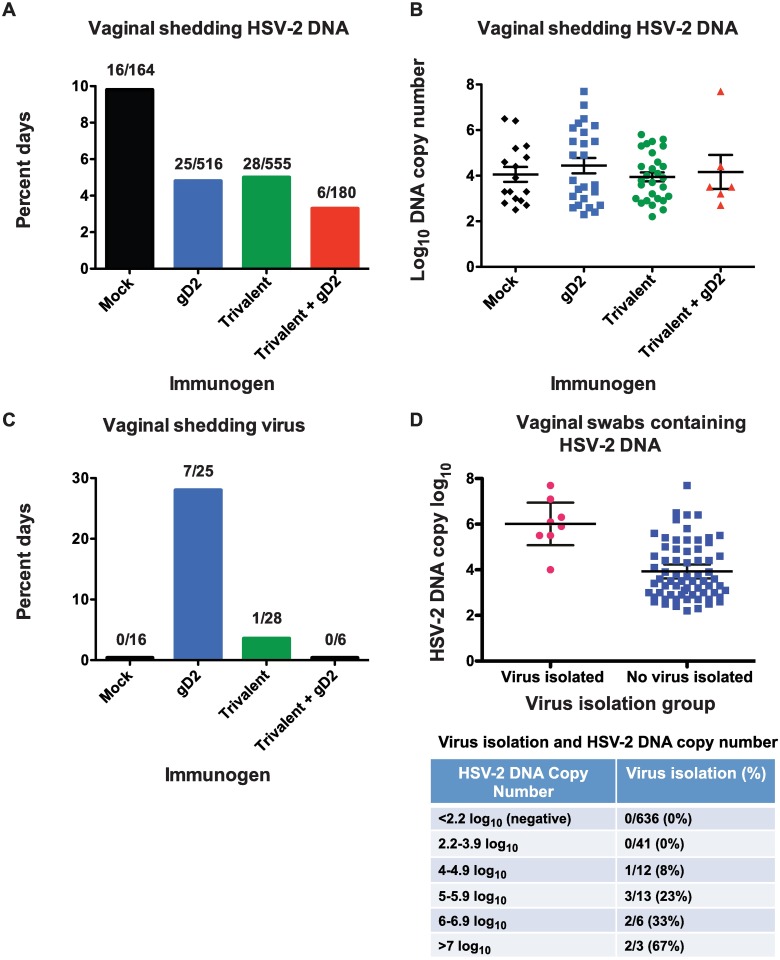
Vaginal shedding of HSV-2 DNA and replication competent virus in guinea pigs from days 29–49 post-challenge.(A) Percent of days with vaginal shedding of HSV-2 DNA. Results shown are from 8 animals in mock, 25 in gD2, 27 in trivalent, and 9 in trivalent + gD2 groups. P values were calculated using Fisher’s exact test. (B) Log10 HSV-2 DNA copy number during episodes of vaginal shedding of HSV-2 DNA. P values were calculated using the Mann Whitney test. (C) Percent days of vaginal shedding of virus. P values were calculated using Fisher’s exact test. (D) HSV-2 DNA copy number in vaginal swabs that yielded replication competent virus and vaginal swabs that failed to grow virus. P value was calculated by the Mann Whitney test. Table below (D): Isolation of replication competent virus at various HSV-2 DNA copy number in vaginal secretions. Only samples from the second vaccine experiment were cultured on days when no HSV-2 DNA was detected.